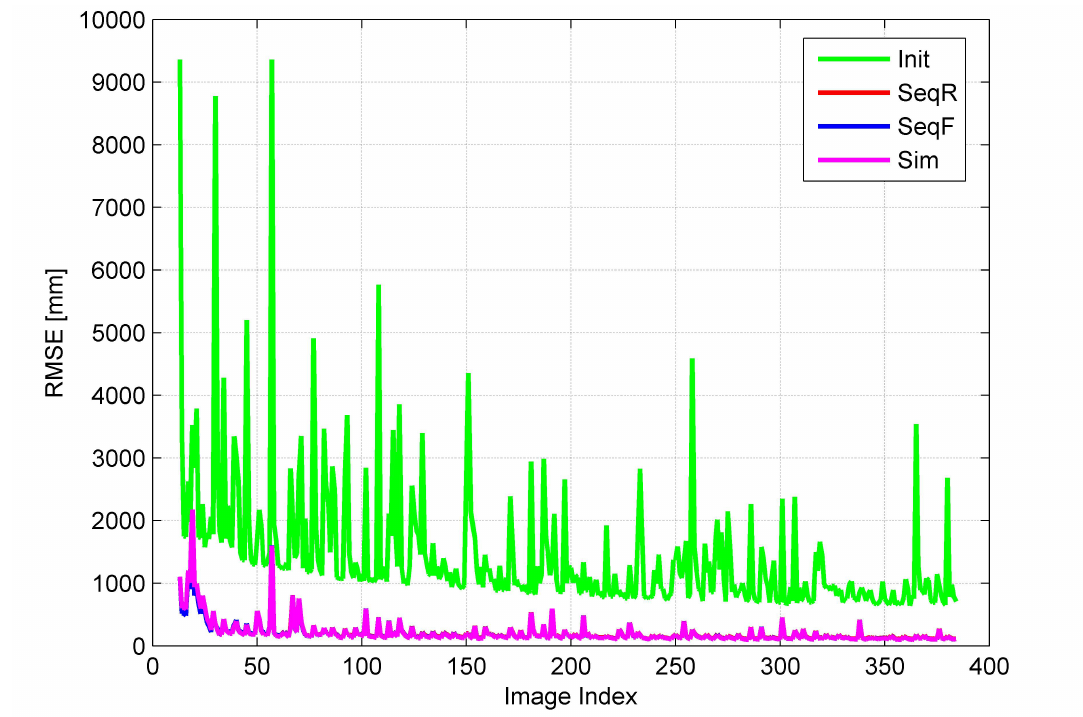
Figure 6. RMSE of estimated ground point coordinates.